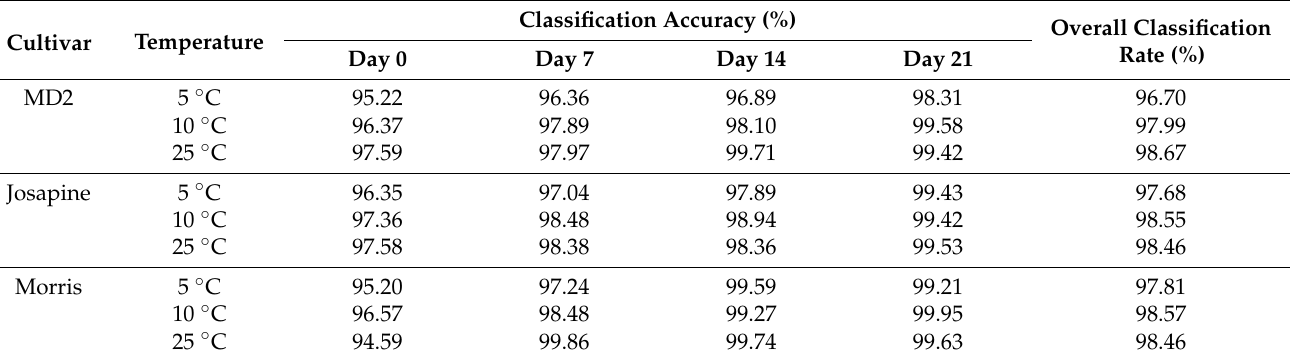
Table 6. Classification performance of pineapple cultivars at different storage days and temperatures using decision